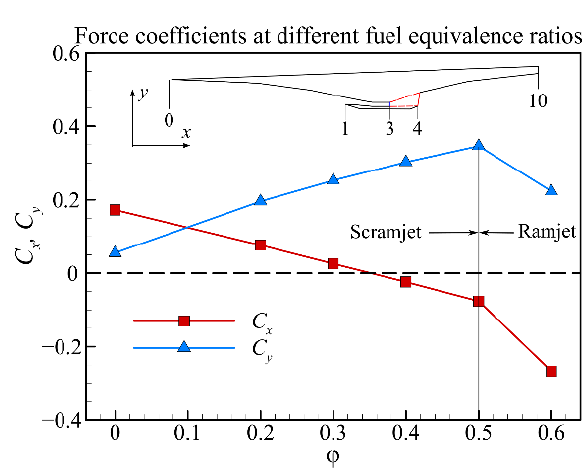
Figure 10. Horizontal and vertical force coefficients at fuel equivalence ratios in the range of 0 to 0.6. The horizontal and vertical forces containing pressure and skin friction terms are integrated from the external and internal surfaces of the hypersonic vehicle. The horizontal force coefficient is positive at ϕ = 0, which represents the drag with the combustor